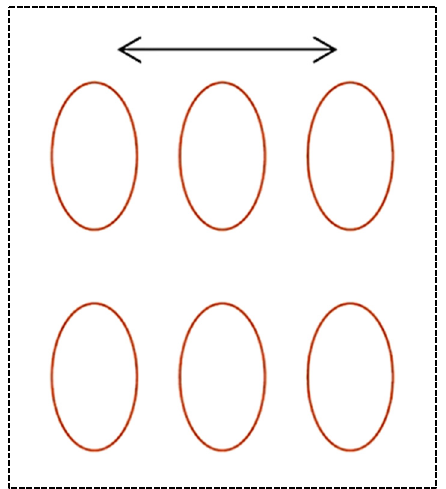
Figure 26. Array of dimples, after [137].